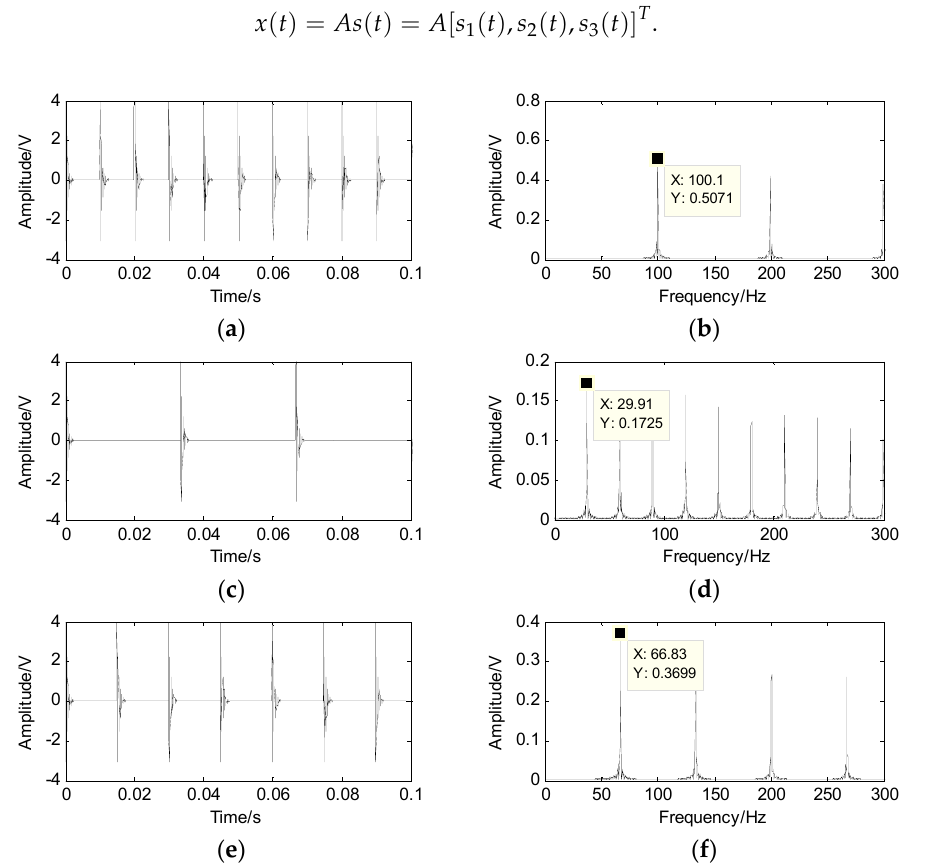
Figure 2. Source signal and its spectrum. ( a ) the waveform of s 1 ; ( b ) the spectrum of s 1 ; ( c ) the waveform of s 2 ; ( d ) the spectrum of s 2 ; ( e ) the waveform of s 3 ; ( f ) the spectrum of s 3 .